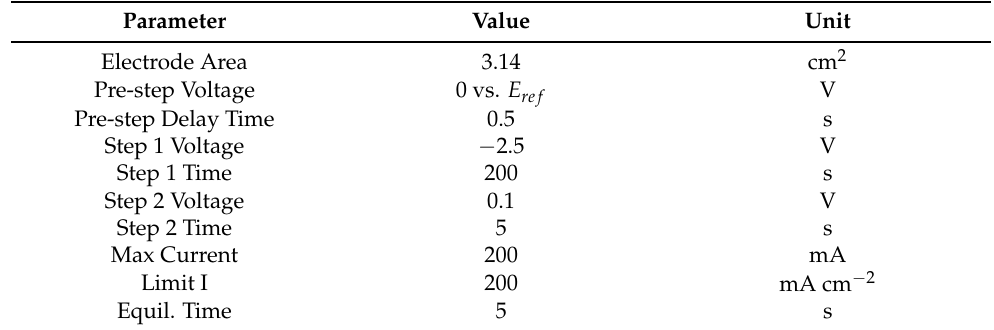
Table 2. Parameters for the chronoamperometry